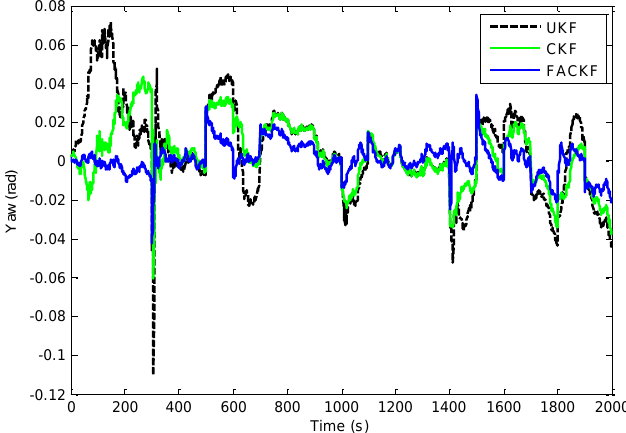
Figure 9. Comparison of yaw angle errors for UKF, CKF, and FACKF—Scenario 1. Table 4. Summary of RMS errors and the time consumption for Scenario 1. RMS Errors (in Units of m for Positions